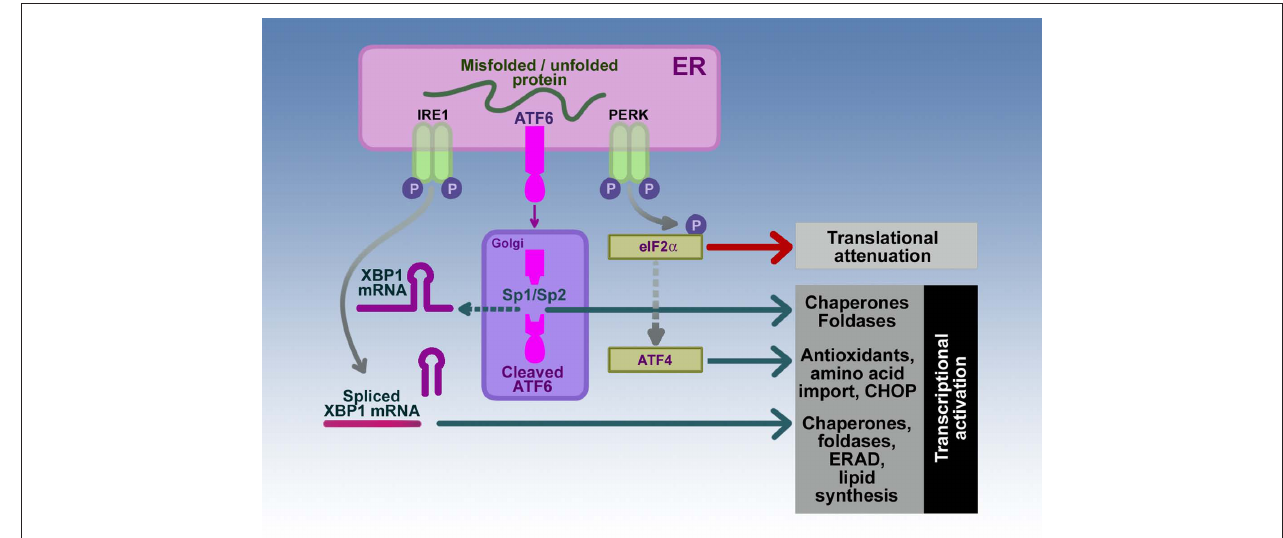
combined effects of IRE1 and ATF6; or translational attenuation and transcriptional upregulation pathways involved in antioxidant synthesis and cell death through the transcription factor C/EBP homologous protein (CHOP) as in the case of PERK. The participants in the pathways involved in the downstream effects of IRE1, ATF6, and PERK activation include X-box binding protein1 (XBP1), site-1 and site-2 proteases (Sp1/Sp2), and eukaryotic translation initiation factor-2a (eIF-2a), and activating transcription factor-4 (ATF4) as discussed in the